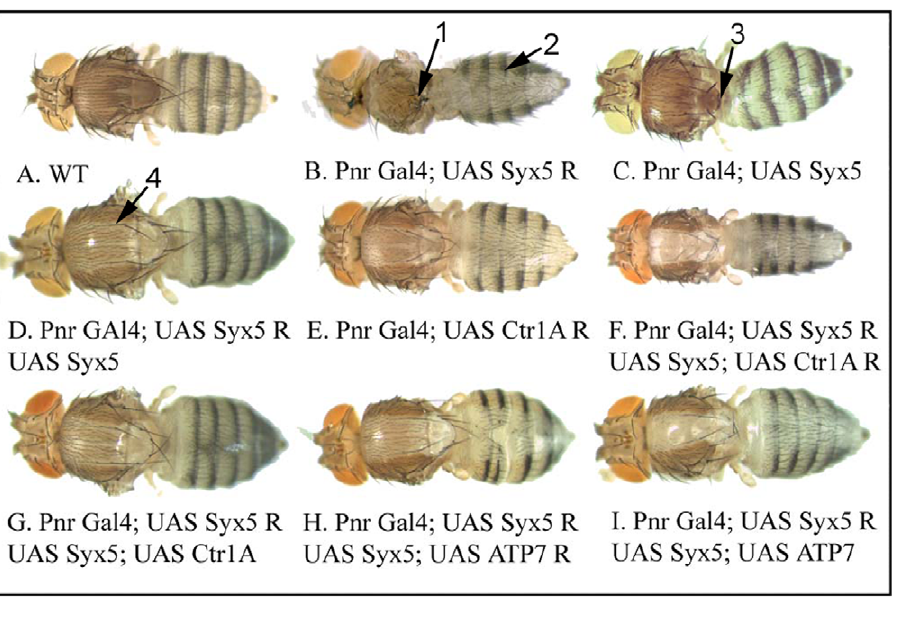
Figure 3. Suppression of Syx5 in adult Drosophila cuticle results in hypopigmentation typical of copper deficiency. Gene expression/ suppression was driven in a dorsal stripe down the adult thorax/abdomen using the Pannier-GAL4 driver. A control fly is shown (A). Syx5 suppression under Pnr-GAL4 is normally lethal. Rare survivors reared at 18 u C (B) show loss of dorsal thorax (arrow 1) and strong abdominal hypopigmentation (arrow 2). Syx5 over-expression results in reduced bristles and scutellum (C, arrow 3). Syx5 suppression can be rescued to a mild hypomorph by concurrent Syx5 over-expression (D), which shows hypopigmentation (arrow 4) similar to that seen for Ctr1A suppression (E). The mild hypomorph is exacerbated by Ctr1A co-suppression (F) but not rescued by Ctr1A over-expression (G). DmATP7 suppression (H) and over-expression (I) phenotypes are unaffected by addition of the Syx5 hypomorph combination.